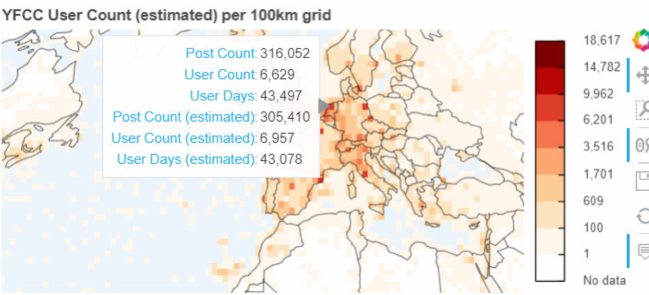
Figure 5. Screenshot of map for user counts per 100 km grid bin, allowing interactive comparison of estimated values (HLL) and exact counts (raw) (see Figure A1 for a static, worldwide view of the map, and Supplementary Materials S8 for the interactive version).